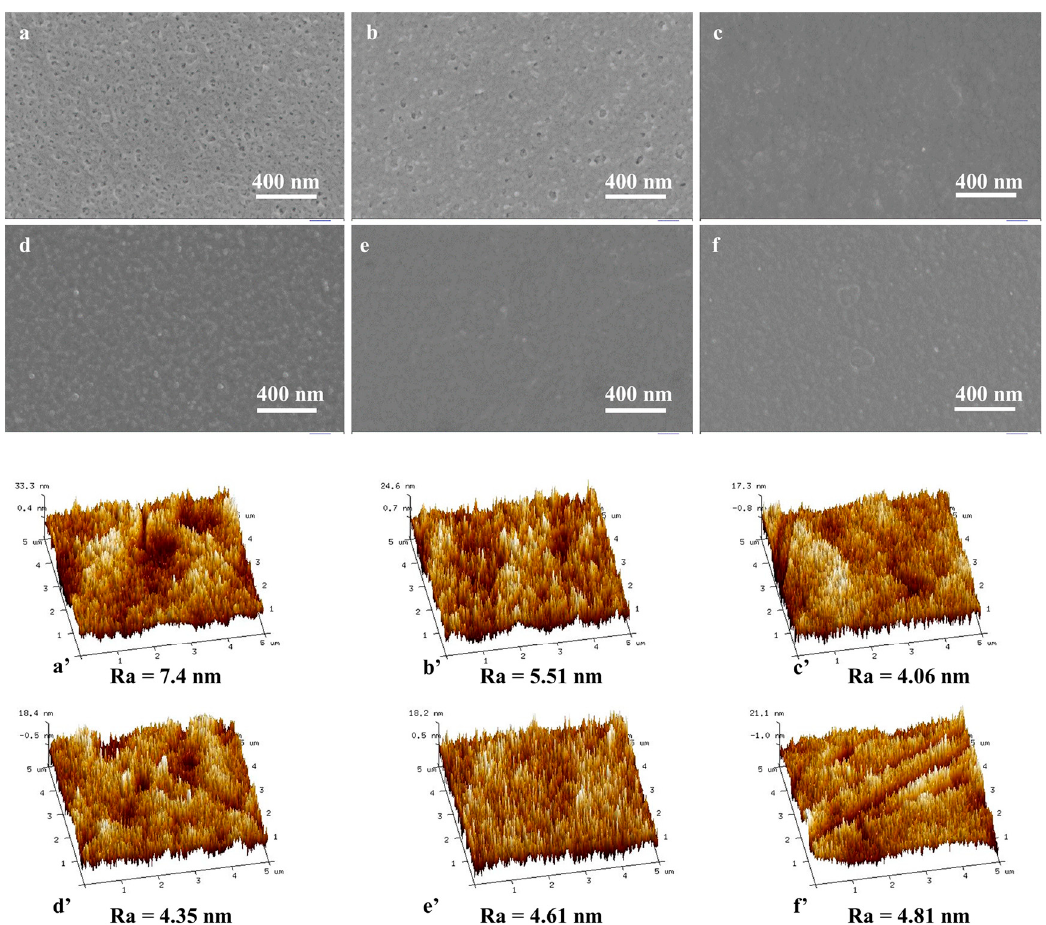
Figure 3. Surface morphologies images of loose TFC NF membranes and PES membrane by FESEM and AFM: ( a , a’ ) PES; ( b , b’ ) PES–DPS–0.5; ( c , c’ ) PES–DPS–0.75; ( d , d’ ) PES–DPS–1; ( e , e’ ) PES–DPS–2; and ( f , f’ ) PES–DPS–3.